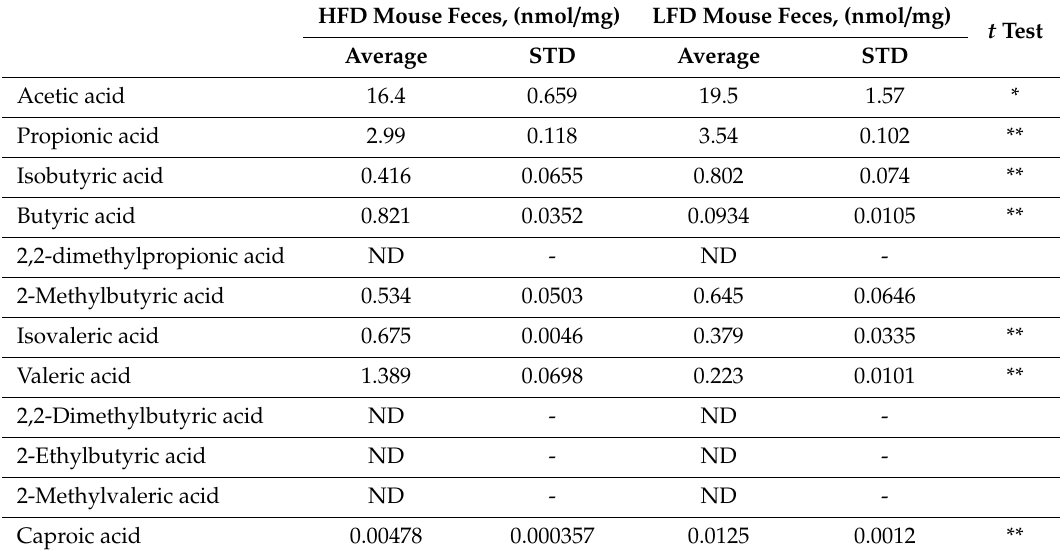
Table 3. Quantitation of SCFAs in mice feces fed with high-fat (HFD) or low-fat (LFD) diet. Averages and STDs (standard deviations) of SCFAs were calculated by using three feces samples taken from three mice. ** indicates if p -value < 0.01 and * if p < 0.05 ( t test). ND represents “not